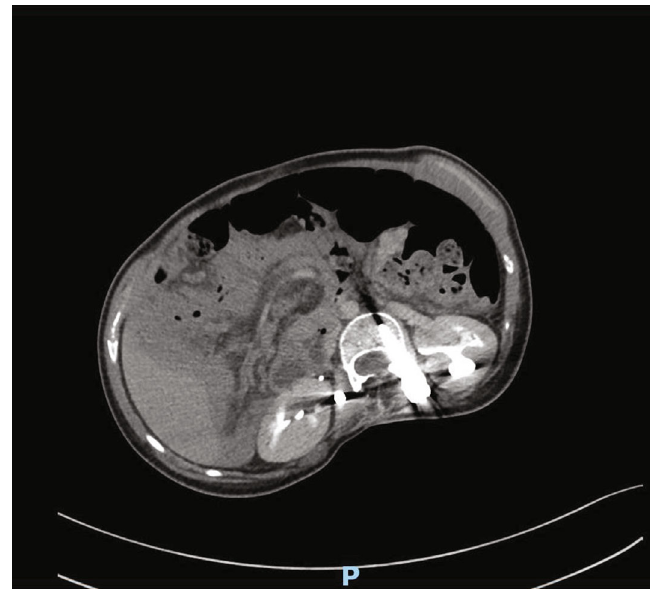
Figure 1: Whirl sign.